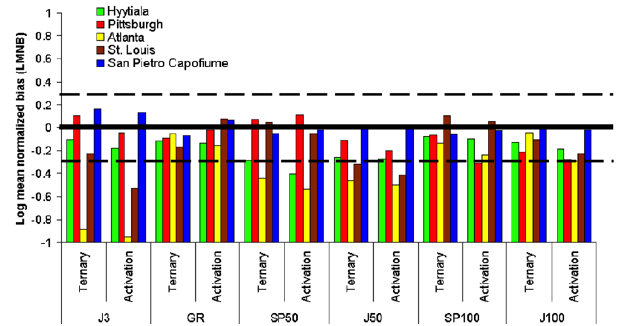
Fig. 12. Log-mean normalized bias (LMNB) values for each metric and each site for both the ternary and activation simulations. Solid line represents no model bias, whereas dashed lines signify biases of a factor of 2 (high and low). For each site and each metric, we plot the LMNB value. LMNB is the average number of orders of magnitude error, e.g., a value of − 0.3 means that the model under- predicts the measurements by about a factor of 2. The dashed line means zero bias in the model